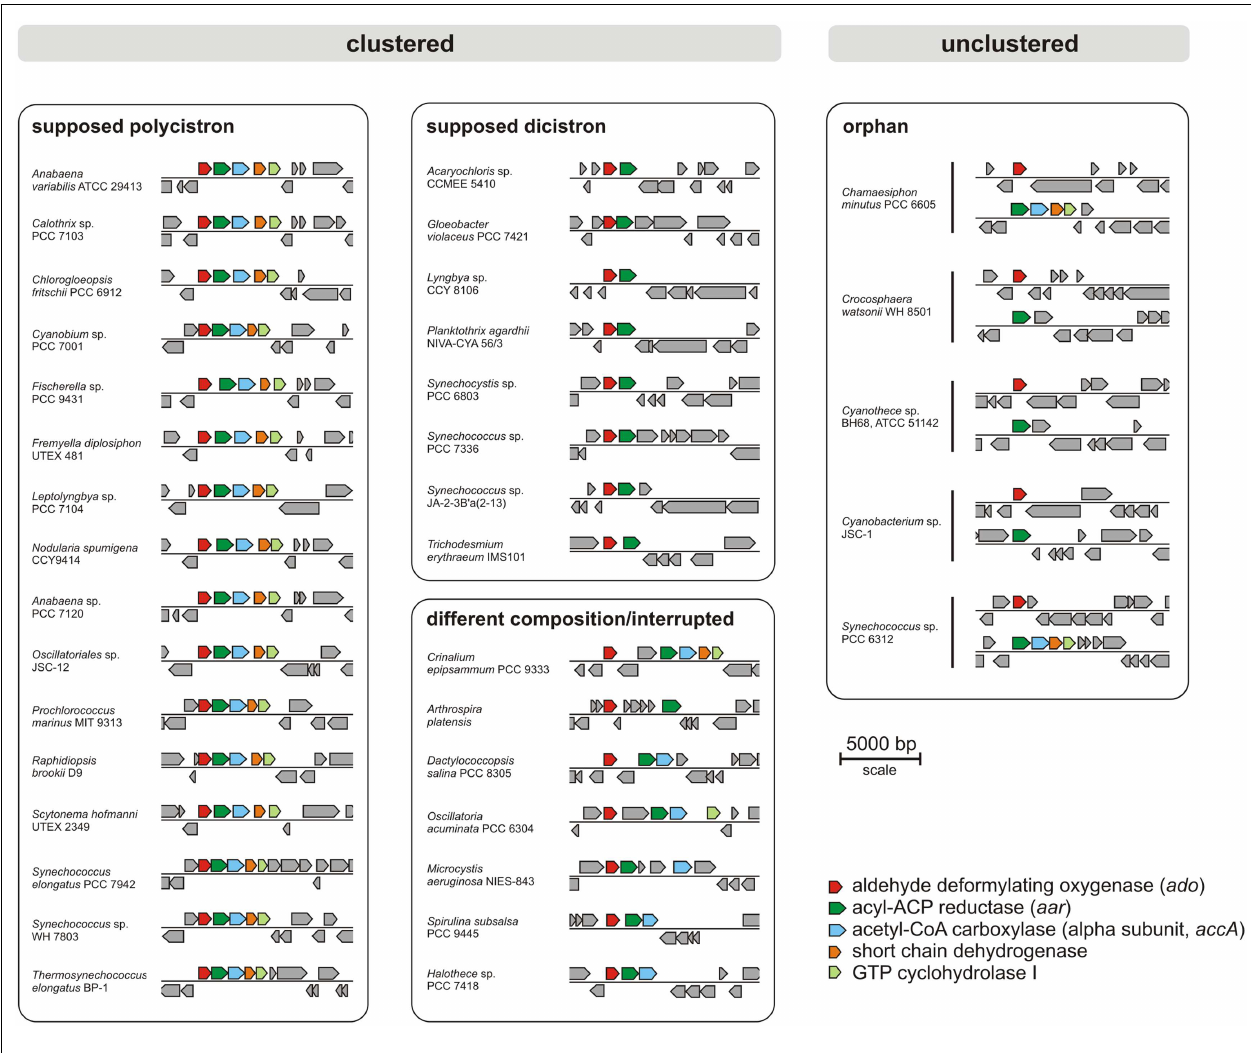
genomes were screened for the presence of alkane biosynthesis genes.The corresponding protein sequences from Synechocystis sp. PCC 6803 were used as